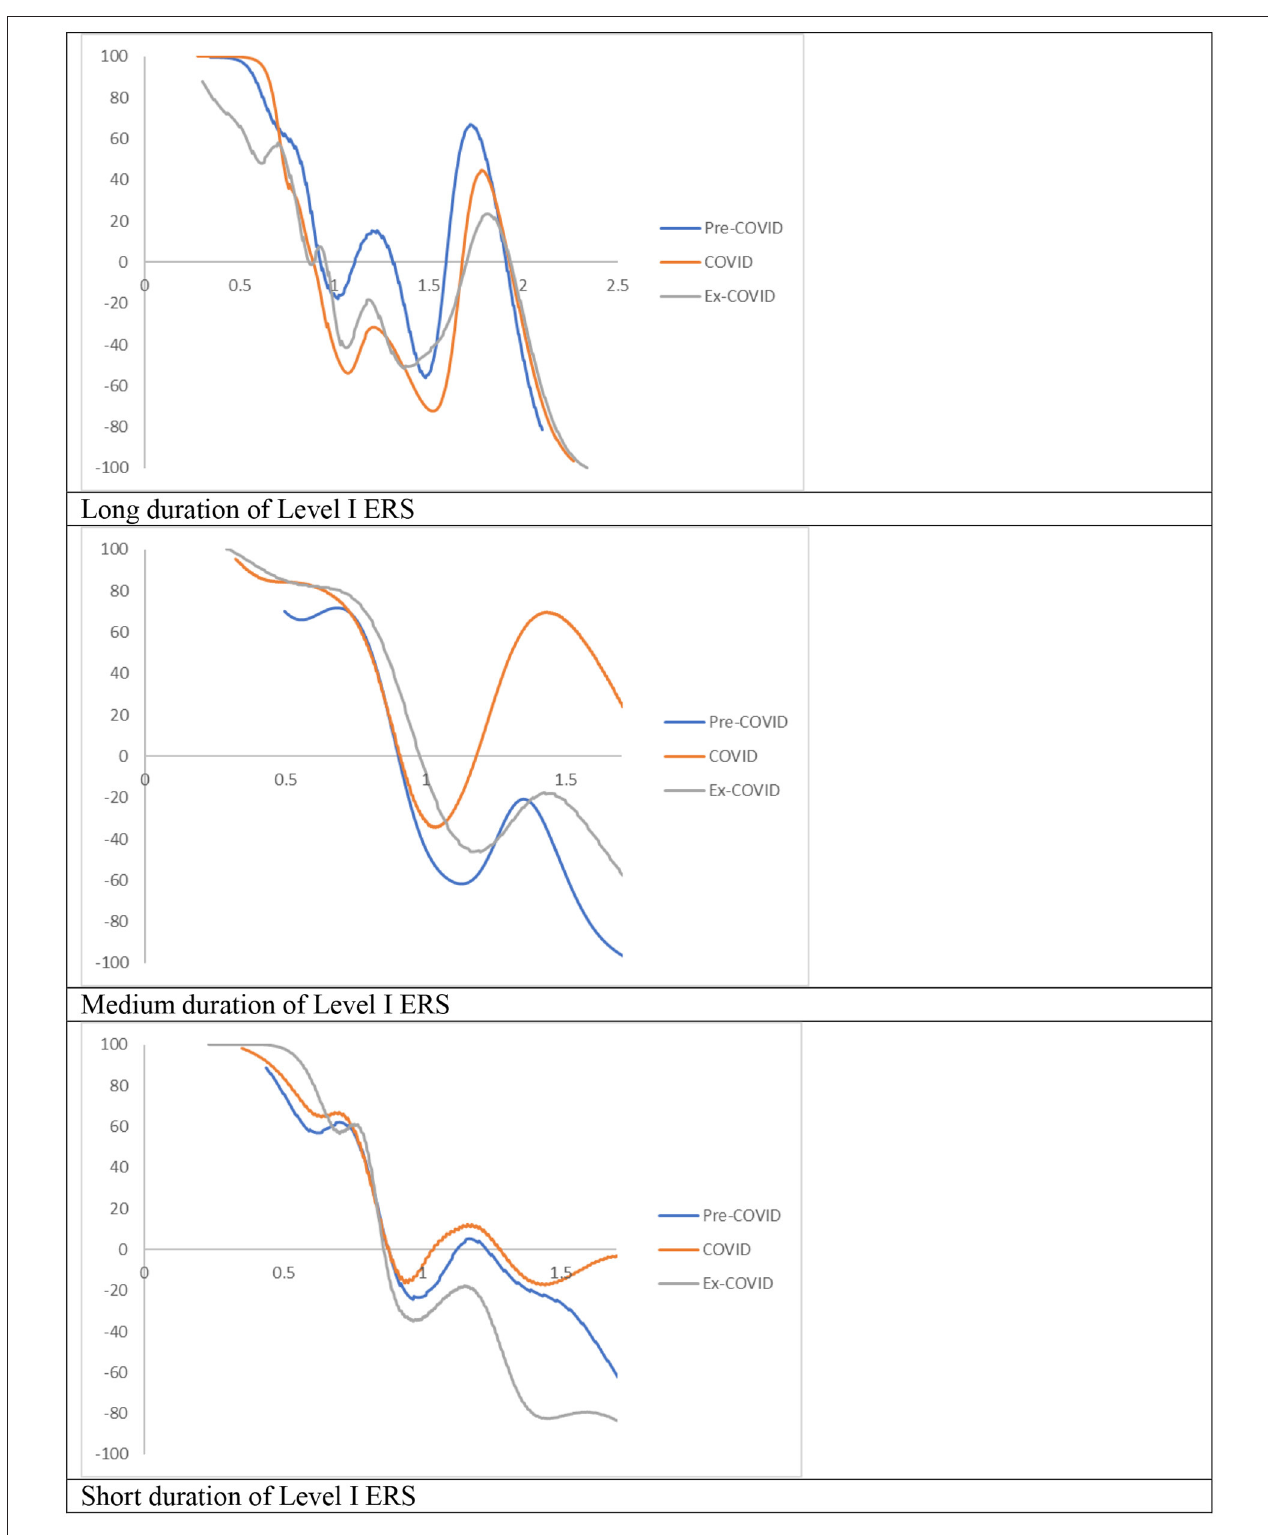
FIGURE 10 | Mobility probability plot (MPP) for the RDIPC of urban residents in cities with long, medium, and short duration of Level I ERS with quarterly transitions. Source: authors’ calculation. N.B. The vertical axis indicates net upward mobility (%) and the horizontal axis indicates RDIPC values.